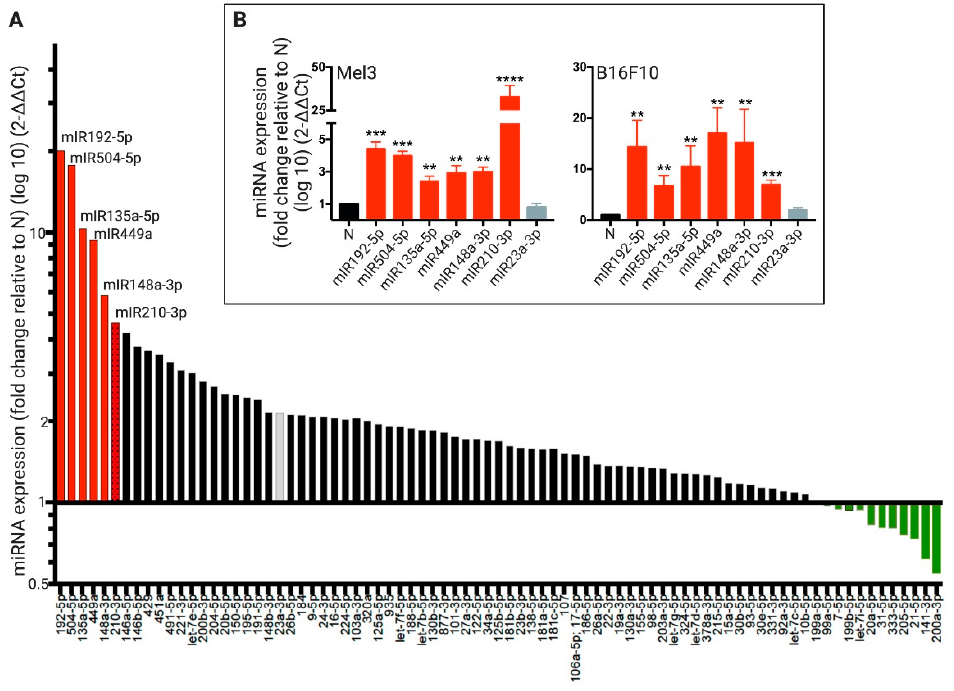
Figure 3. Identification of hypoxia-induced miRNAs in human and murine melanoma cells. ( A ) Human melanoma cells (Mel1, Mel2, and Mel3) were cultured in normoxic (21% O 2 ; N) or hypoxic (1% O 2 ; H) conditions for 72 h and total RNA samples (including miRNAs) were isolated. The expression levels of 84 hypoxia-associated miRNAs were determined by qRT-PCR arrays using pooled RNA samples. The levels of expression for each miRNA were obtained by the ∆ / ∆ Ct method, normalized to the expression levels of di ff erent control small RNAs and expressed as fold change relative to N condition. The red bars show the top-6 hypoxia-induced miRNAs. The green bars show the hypoxia-down regulated miRNAs. ( B ) Mel3 cells were incubated in N or H for 72 h, while B16F10 were incubated in the same conditions for 24 h. Total RNA samples (including miRNAs) were isolated and the expression levels of miR-192-5p, -504-5p, -135a-5p, -449a, -148a-3p, and -210-3p, the top-6 hypoxia-induced miRNA, identified in ( A ), were evaluated by independent qRT-PCR assays. In addition, the expression level of miR-23a-3p, a miRNAs weakly induced by hypoxia identified by the qRT-PCR array (A, gray bar), also was evaluated by independent qRT-PCR assays. The levels of miRNA expression were obtained by the ∆ / ∆ Ct method, normalized to small nuclear RNA RNU6-2 expression and expressed as fold change relative to N condition. ** p < 0.01; *** p < 0.001; **** p < 0.0001 (two-tailed Student’s t -test).